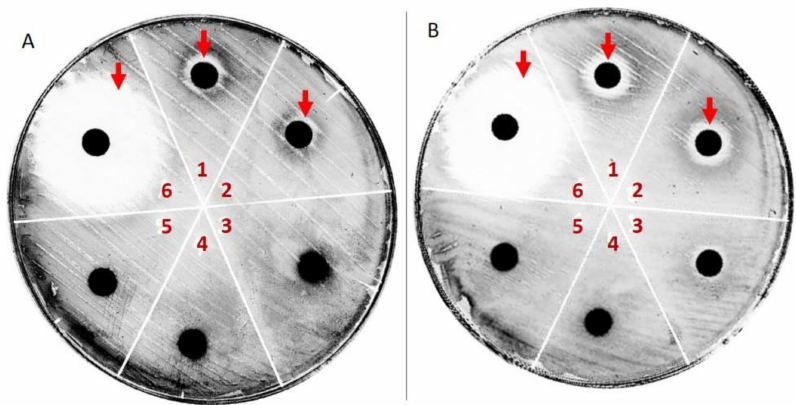
Figure 4. S. aureus growth inhibition by ripe pu-erh extract (plate A ) and raw pu-erh extract (plate B ) at a concentration of 5 mg/mL (sector 1), 2.5 mg/mL (sector 2), 1.25 mg/mL (sector 3), 0.625 mg/mL (sector 4) or 0.3125 (sector 5). Chloramphenicol (sector 6) was used as reference